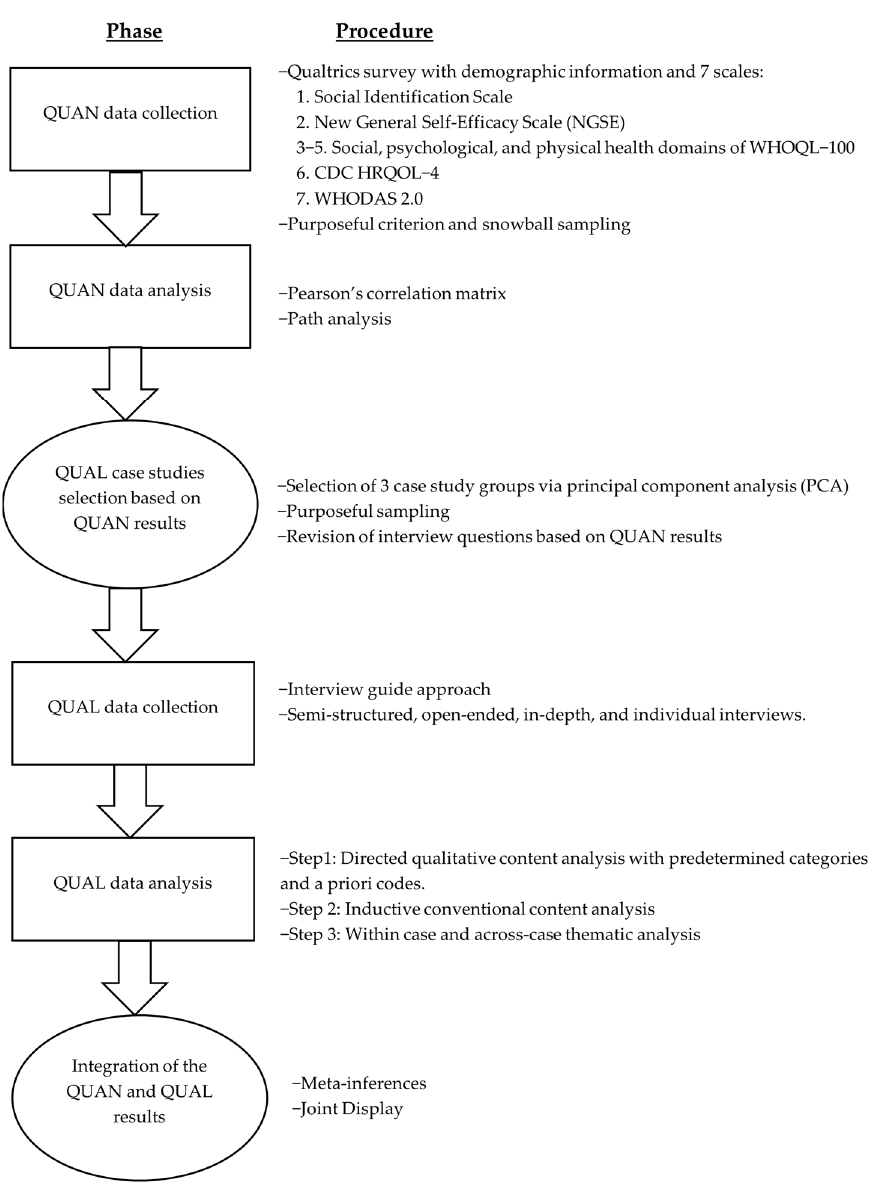
Figure 1. Mixed methods design diagram.